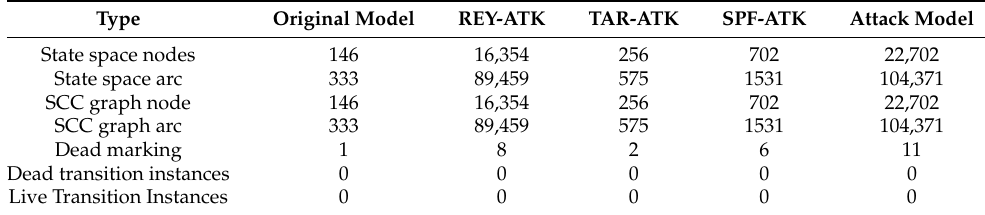
Table 3. Comparison of model state